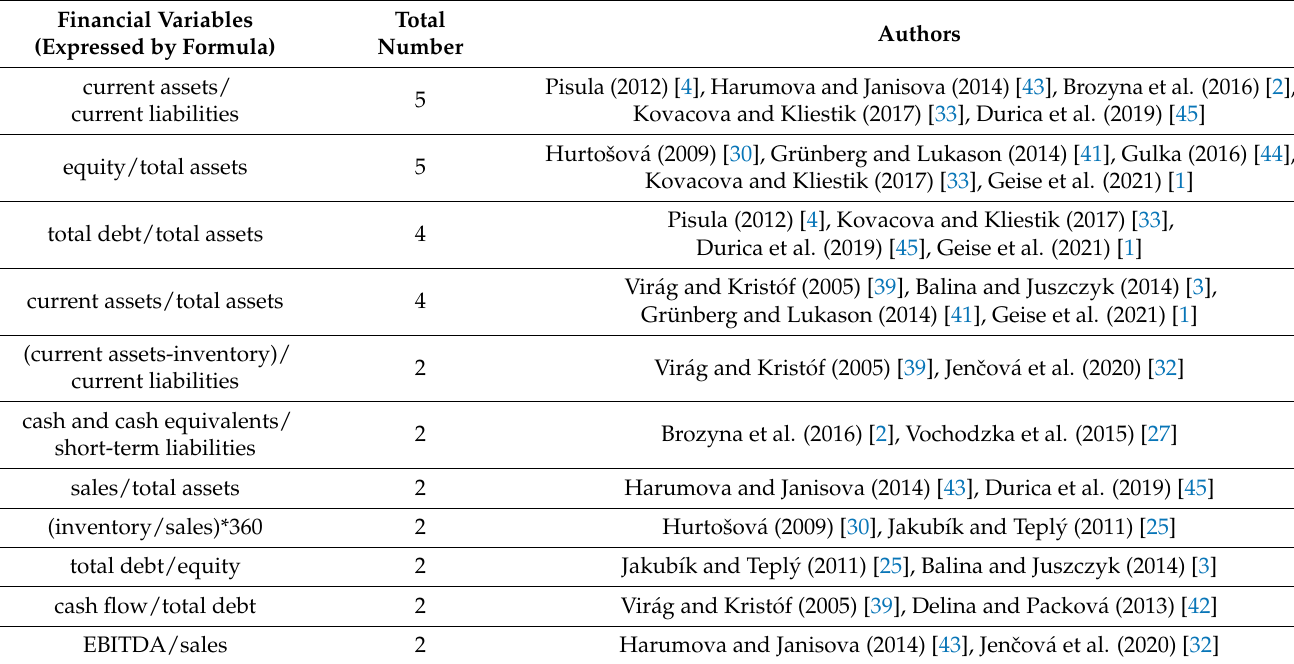
Table 1. The summary of significant variables from the logit model mainly for Central